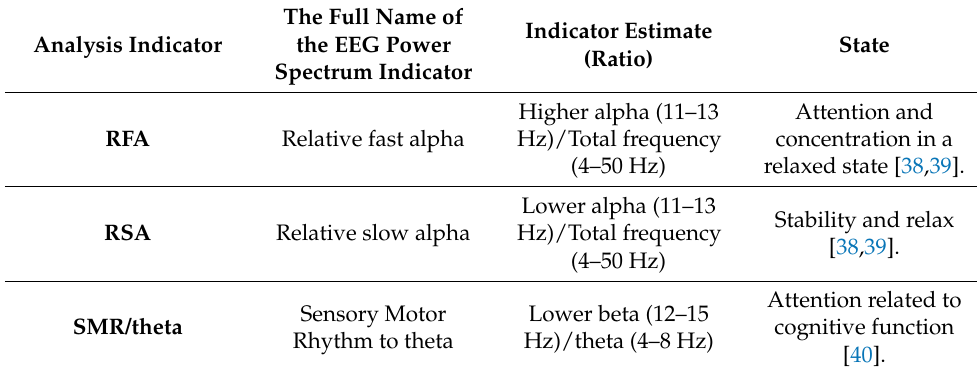
Table 1. EEG power spectrum indicators used in this study.